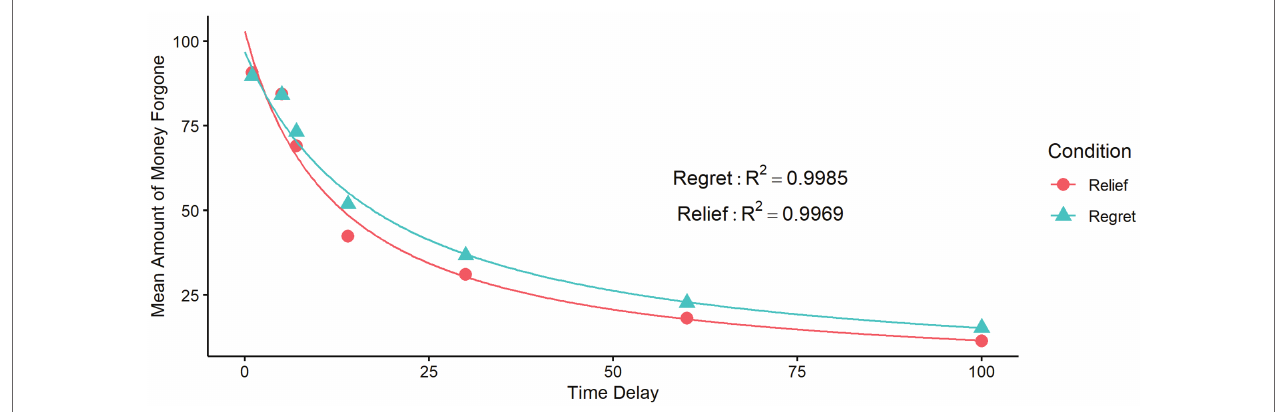
FIGURE 3 | Fitting of the hyperbolic discounting function for the relief (RF) and regret (RT) conditions.